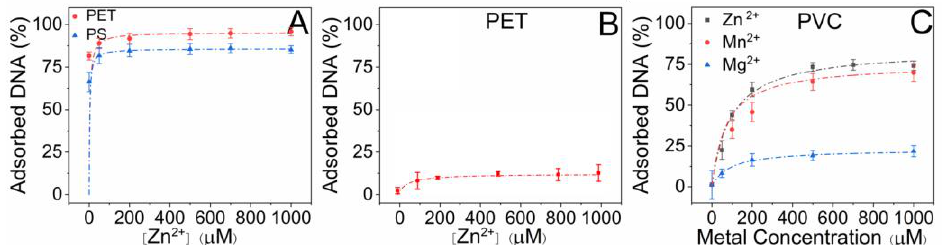
Figure 3. ( A ) Adsorption of 1 μM (DNA base concentration) salmon sperm dsDNA (~2000 bp) onto 500 μg/mL of PS and PET microplastics in the presence of different concentrations of Zn 2+ in a buffer (10 mM HEPES, pH 7.6). ( B ) Adsorption of 100 nM short dsDNA (24 bp) onto 500 μg/mL of PET microplastics in the presence of different concentrations of Zn 2+ in a buffer (10 mM HEPES, pH 7.6). ( C ) Adsorption of 1 μM salmon sperm dsDNA (~2000 bp) onto 500 μg/mL of PVC microplastics in the presence of different concentrations of various metal ions in a buffer (10 mM HEPES, pH 7.6).